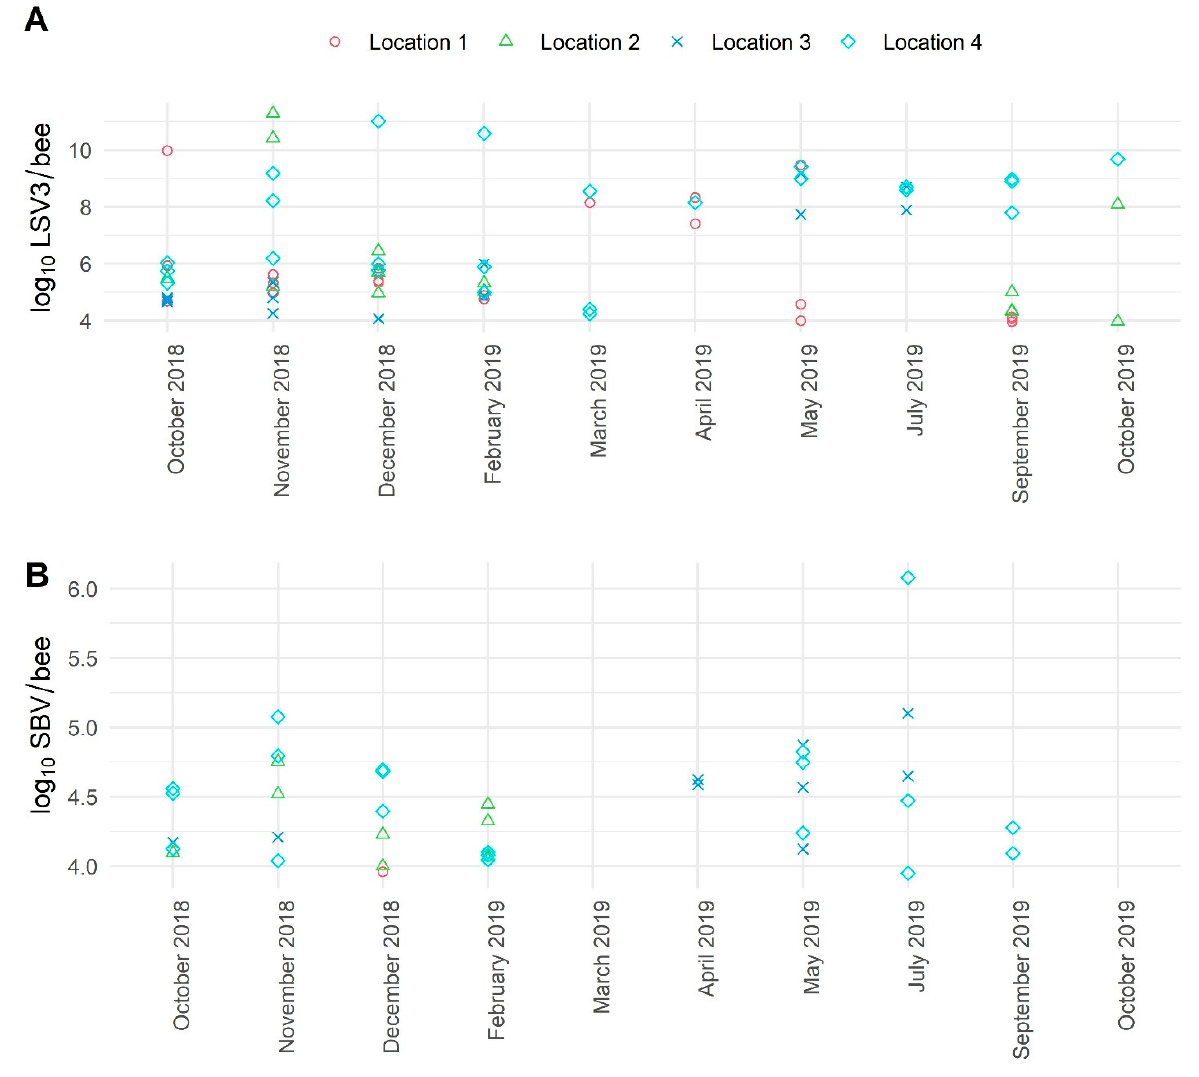
Figure 5. The detected average viral loads of positive samples for LSV3 ( A ) (no. of samples: 109, no. of positive samples: 73) and SBV ( B ) (no. of samples: 109, no. of positive samples: 38) of healthy adult honeybees during the 10 months of sampling. One symbol represents one positive honeybee sample consisting of 10 honeybees.